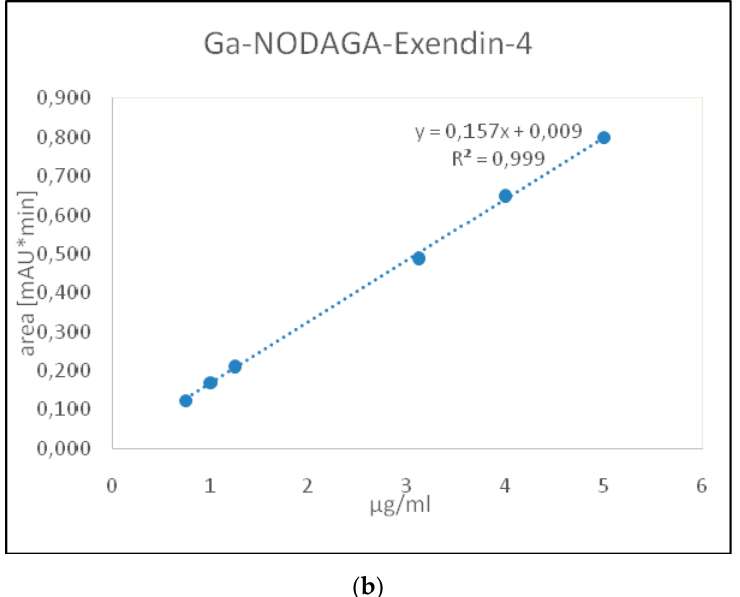
Figure 2. Calibration curve obtained with the average values of peak areas of six different concentrations (5, 4, 3.125, 1.25, 1, and 0.75 µg/mL) of NODAGA-exendin-4 ( a ) and Ga-NODAGA-exendin-4 ( b ), respectively. For each concentration of NODAGA-exendin-4 and Ga-NODAGA-exendin-4 the peak areas were measured and a mean value for each was calculated to obtain the calibration curve: 0.7986 ± 0.0020, 0.6495 ± 0.0022, 0.4893 ± 0.0029, 0.2117 ± 0.0010, 0.1704 ± 0.0014, 0.1251 ± 0.0002 mAU*min for NODAGA-exendin-4 and 0.7989 ± 0.0039, 0.6493 ± 0.0019, 0.4893 ± 0.0030, 0.2122 ± 0.0004,